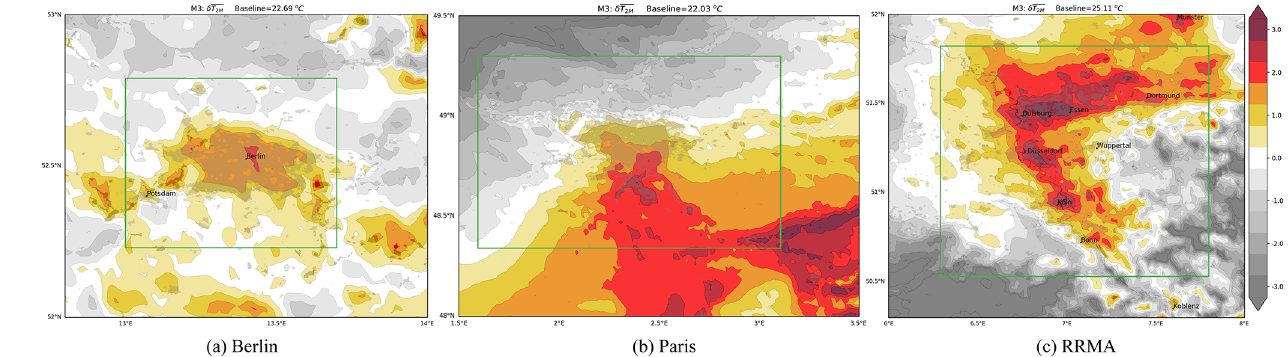
Figure 4. UHI calculated with M3 on the original grid (no interpolation) for Berlin, Paris and the Rhine-Ruhr Metropolitan Area (a–c) , the limit of the rural points used in the baseline is shown here in the green lines, or in Fig. 1 as the sum of green, purple and orange grid-points.